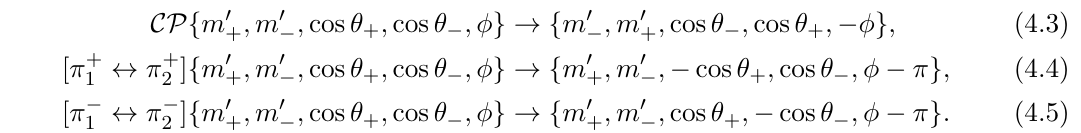
Figure 2 . Two-dimensional slices of the D ! 4 (cid:25) (cid:6) phase space showing the equal (cid:1) (cid:14) 4 (cid:25) with N = 5. The colour denotes the absolute value of the bin number, and the cross hatching denotes a negative bin number. In each of the two-dimensional slices, the remaining three variables are (cid:12)xed to (left) cos (cid:18) + = cos (cid:18) (cid:0) = 0 : 5 and (cid:30) = 0 : 625 (cid:25) (centre) m 0 (cid:30) = 0 : 5 (cid:25) (right) m 0 = m 0 = 932 MeV and cos (cid:18) + = 0 : 425 (cid:25) + (cid:0)